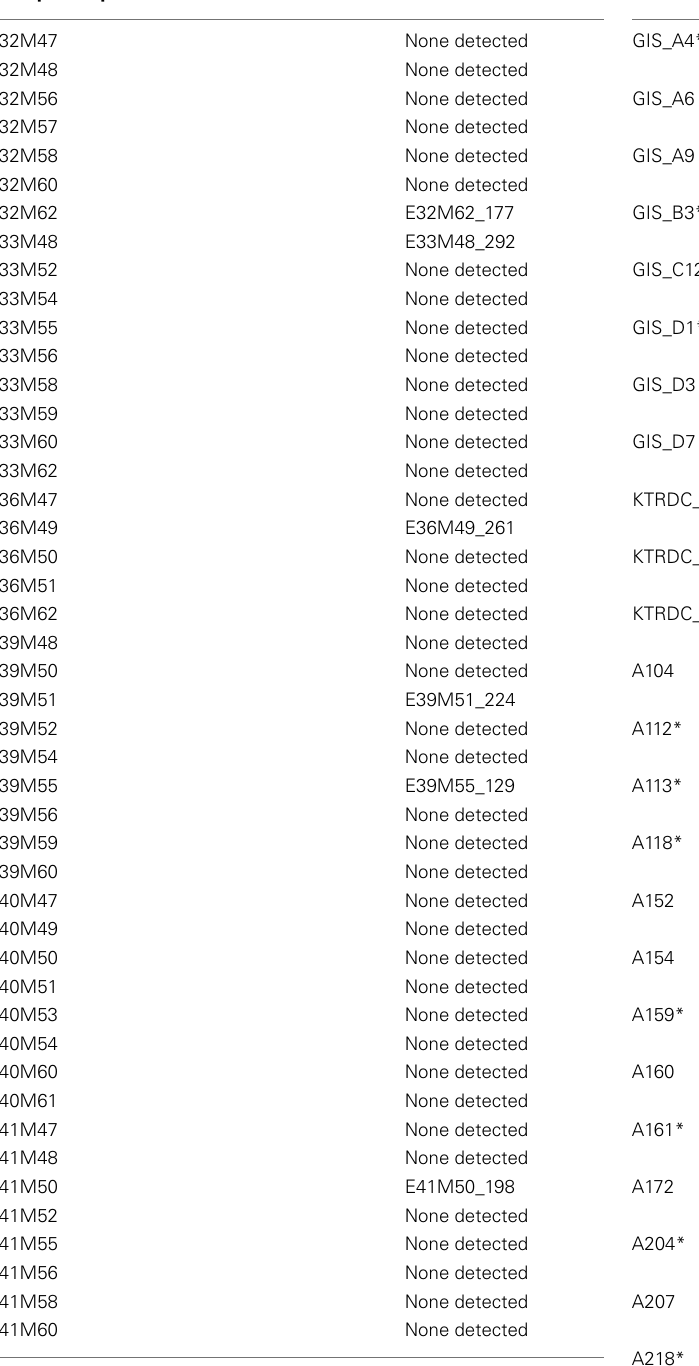
Table 3 | Primers for SSR marker amplification in Nicotiana spp., the NlRPT mapping population, and N. benthamiana ∗